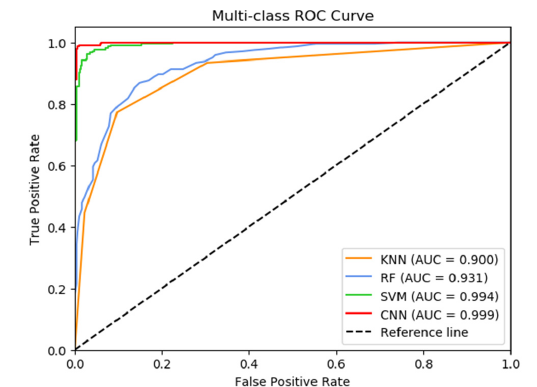
Figure 6. The ROC curves of KNN, RF, SVM and CNN models.